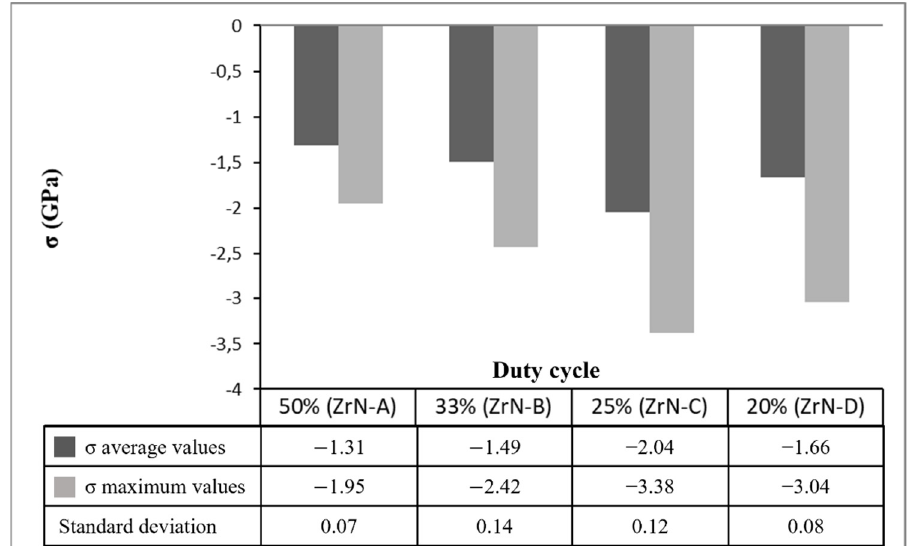
Figure 1. Average, maximum values and standard deviation of compressive residual stress of ZrN films deposited with different duty cycle. The samples name is included in brackets.